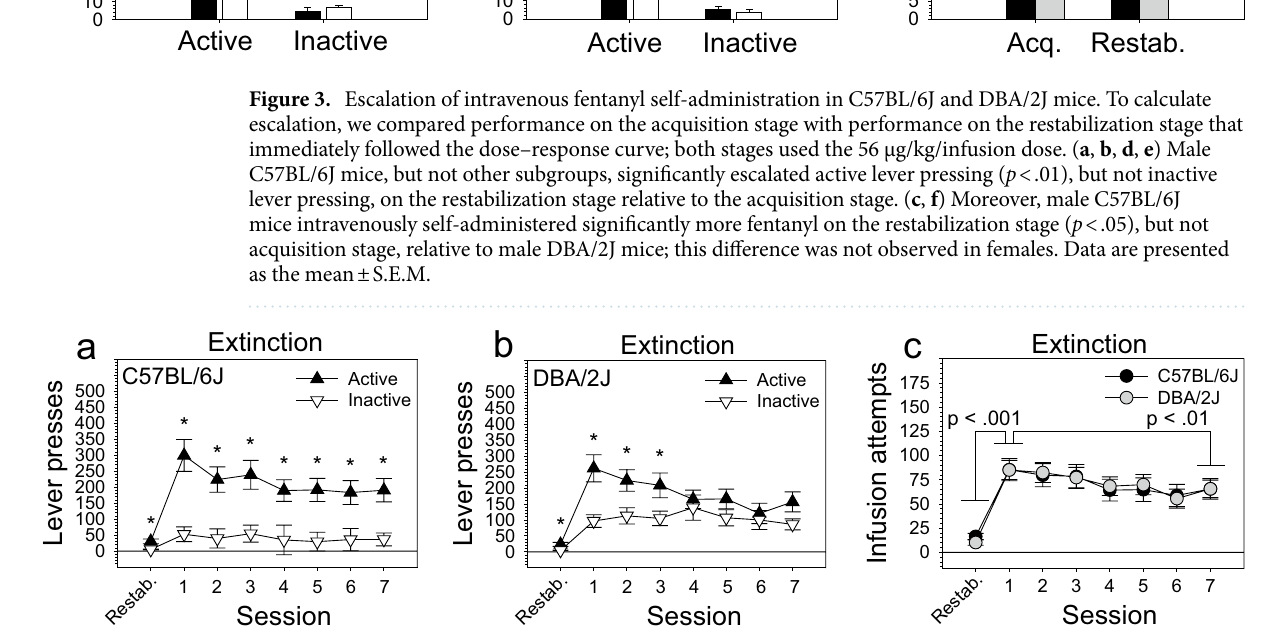
Figure 4. Extinction of intravenous fentanyl self-administration in C57BL/6J and DBA/2J mice. Following the restabilization stage, mice were tested for seven sessions on an extinction stage during which lever pressing had no consequences. ( a , b , c ) Mice exhibited both an extinction burst and extinction of the previously learned operant response. First, mice significantly increased active lever pressing ( p < .001) and infusion attempts ( p < .001) on the first extinction session relative to the restabilization stage (i.e., extinction burst). Second, mice significantly reduced infusion attempts ( p < .01) and active lever pressing ( p < .001), but not inactive lever pressing, on the final extinction session relative to the first extinction session (i.e., extinction of the previously learned response). These phenomena were not influenced by strain or sex. Data are presented as the mean ± S.E.M. * p <